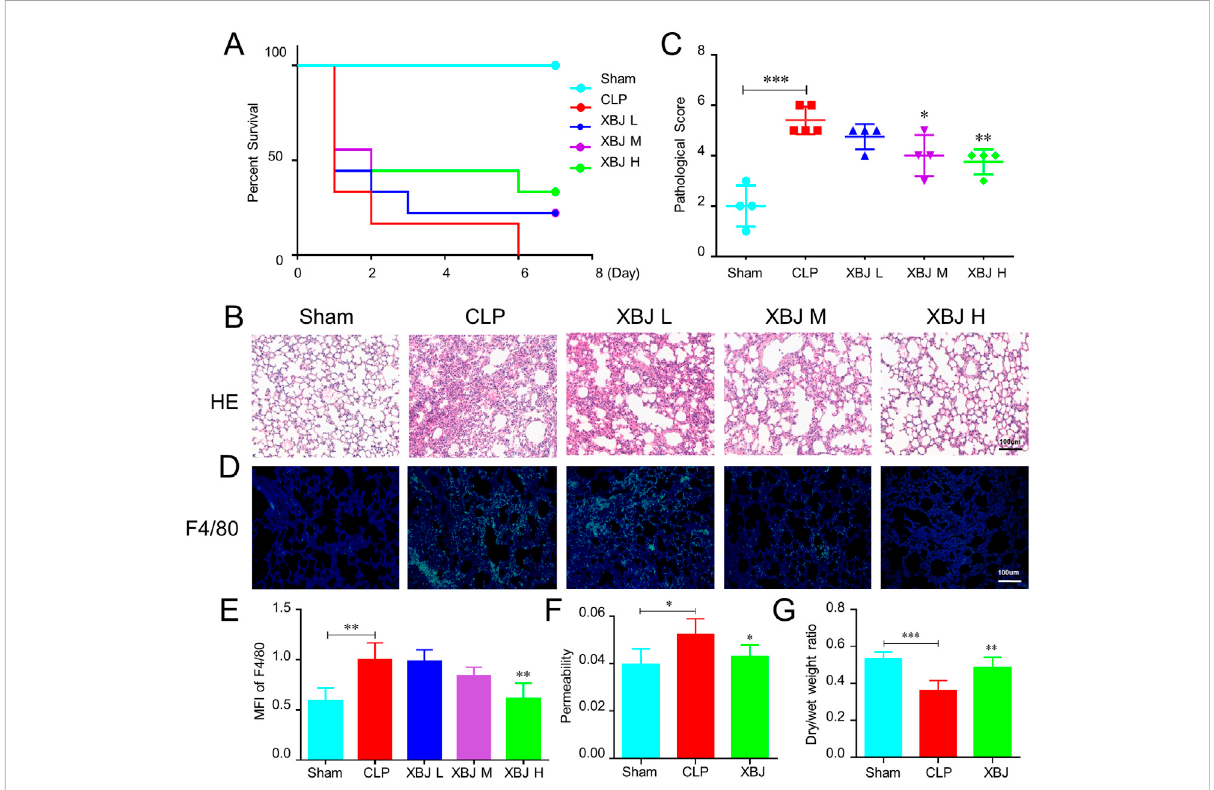
FIGURE 1 XBJ ameliorated sepsis-induced lung injury (A) . The Kaplan-Meier survival curve of different groups of mice. WT mice were subjected to CLP, then were injected (tail vein injection) with XBJ every 12 h indifferent concentrations ( n ≥ 5 mice/group). Survival was monitored within 7 days. Lung tissues were collected from different group mice at 24 h after CLP (B) . The representative images of hematoxylin and eosin-stained lung tissues, whichwereobservedunderlightmicroscopyat×200magni fi cations (C) .Thepathologicalscoresoflungsindifferentgroupswerequanti fi edas describedinMaterialsandMethods( n ≥ 3) (D) .Immuno fl uorescentassaytodetectthemacrophage(F4/80positive)inthelungtissue,DAPI(blue)and F4/80(green)wereshown (E) .ThequantitativeresultofF4/80( n =3). (F,G) showedtheratioofEvansbluedyeextravasationandwet/dryweightratio of lungs, respectively ( n ≥ 5). The values were indicated as mean ± SD. * p < 0.05, ** p < 0.01, *** p < 0.001, compared with the CLP